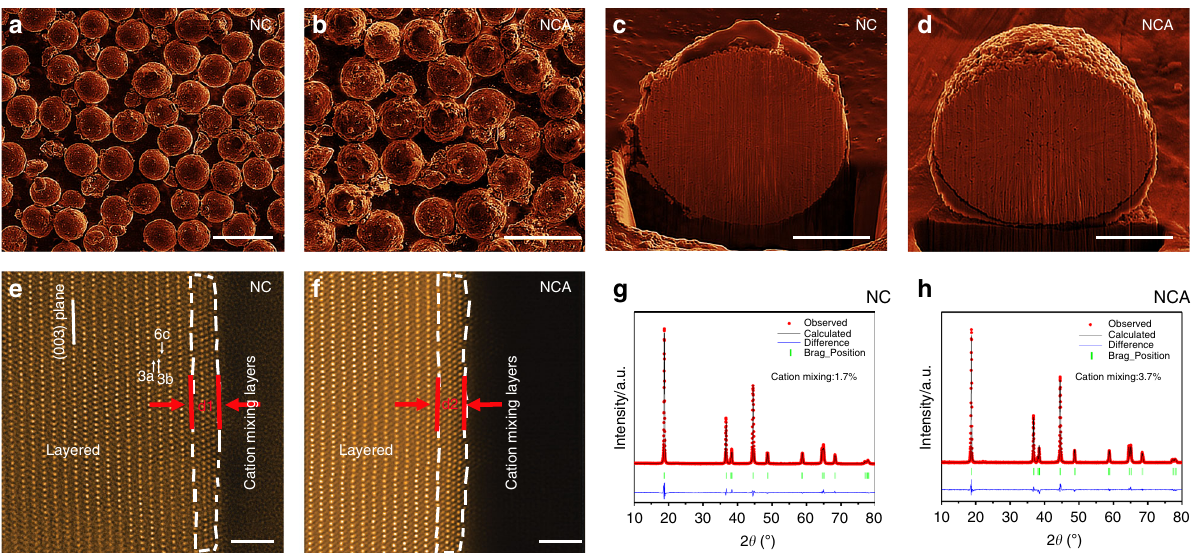
Fig. 1 Surface and bulk characterizations of NC and NCA pristine materials. a , b SEM images of NC and NCA from top view, showing the secondary particles are of spherical shape with narrow size distribution. c , d SEM images of NC and NCA secondary particle from cross-sectional view. e , f Atomic resolution HAADF-STEM images of NC and NCA, seen from [100] zone axis. The white dashed lines outline the cation mixing regions on primary particle surfaces. d1 and d2 represent the thickness of cation mixing layers in NC and NCA, respectively. g , h XRD patterns of NC and NCA with Rietveld re fi nement analysis, the fi tted results are presented in Supplementary Table 1. Scale bar, 20 μ m a , b , 4 μ m c , d , and 20 μ m e ,